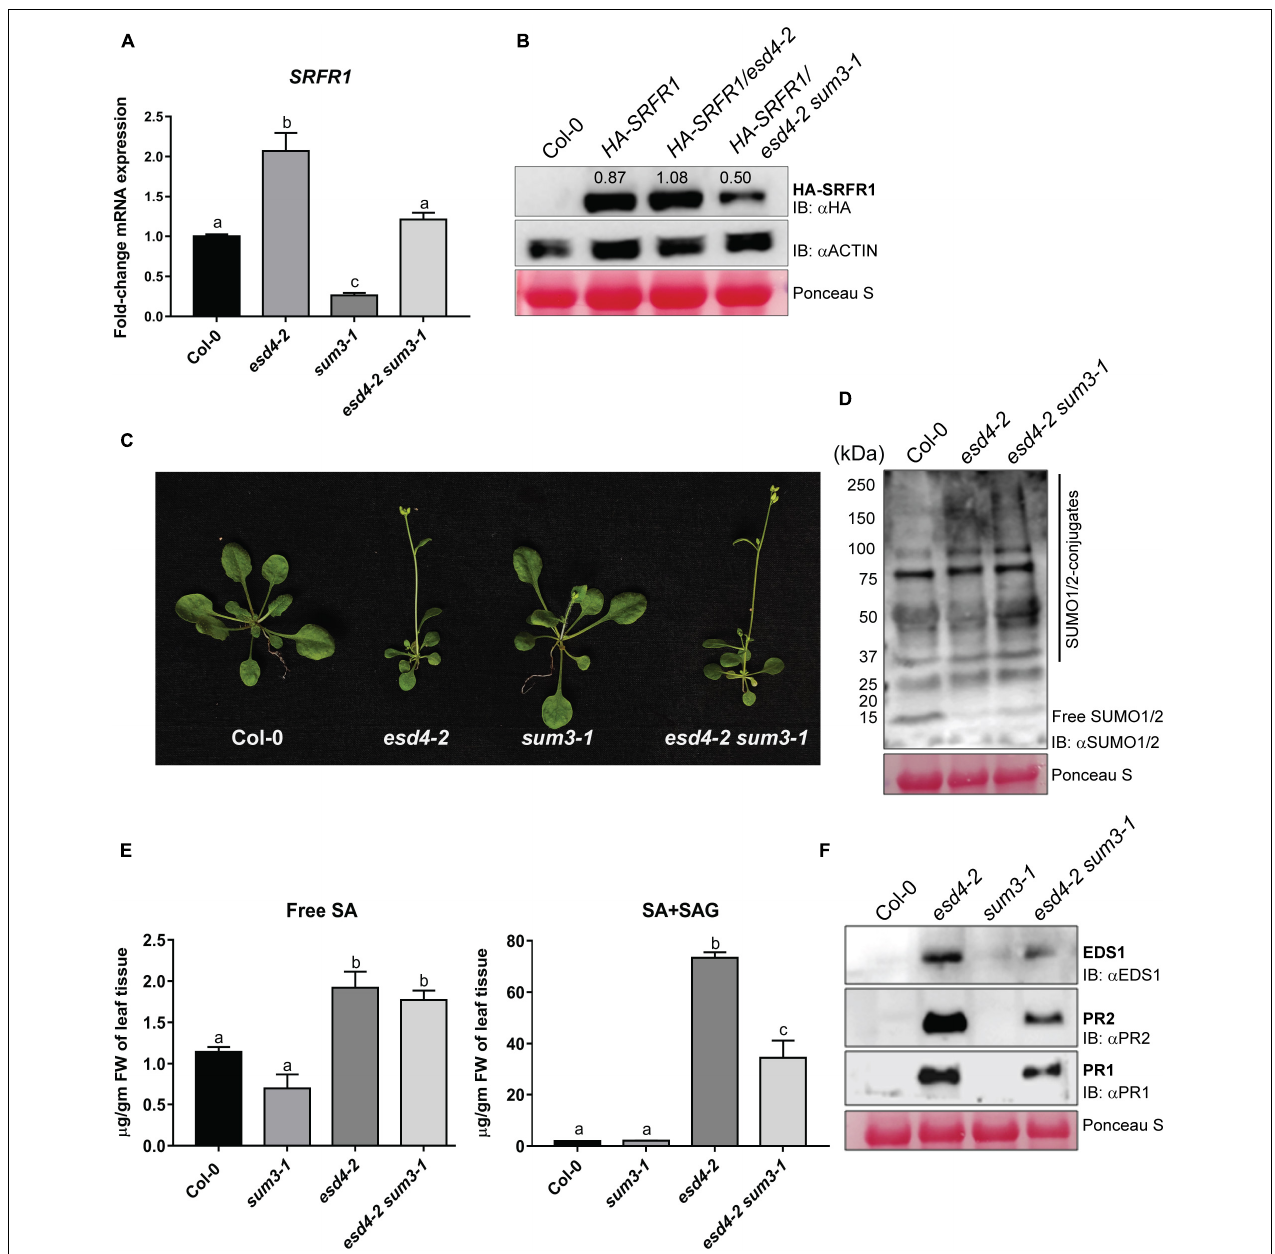
FIGURE 6 | SUM3 is partially responsible for increased defenses but not growth phenotype of esd4-2 . (A) SRFR1 transcript abundance in Col-0, esd4-2 , sum3-1 , and esd4-2 sum3-1 plants. Expressions were compared with MON1 levels and presented as fold-change relative to Col-0 ( n = 3). Statistical significance is by post hoc Tukey’s test ( p < 0.05) and shown by different letters. (B) HA-SRFR1 protein in wild-type ( HA-SRFR1 ), HA-SRFR1 / esd4-2 , and HA-SRFR1/esd4-2 sum3-1 background. Col-0 is the negative control for the immunoblot. (C) esd4-2 sum3-1 plants resemble esd4-2 growth deficiencies. Images are representative of 4-week-old plants of indicated genotypes. (D) Global SUMOylome enhancements in esd4-2 and esd4-2 sum3-1 plants compared with Col-0. (E) Free and total SA levels, and (F) accumulation of EDS1, PR2, or PR1 proteins in esd4-2 , sum3-1 , and esd4-2 sum3-1 plants compared with Col-0. Protein blots were probed with anti-HA, anti-SUMO1/2, anti-EDS1, anti-PR1, or anti-PR2 antibodies, as indicated. Migration positions of SUMO1/2-conjugates, free SUMO1/2, or molecular weight standards (in kDa) are shown. Similar protein loadings are shown by Ponceau S staining. Numbers above the HA-SRFR1 bands in panel (B) are densitometric quantification values relative to actin expression levels in the same